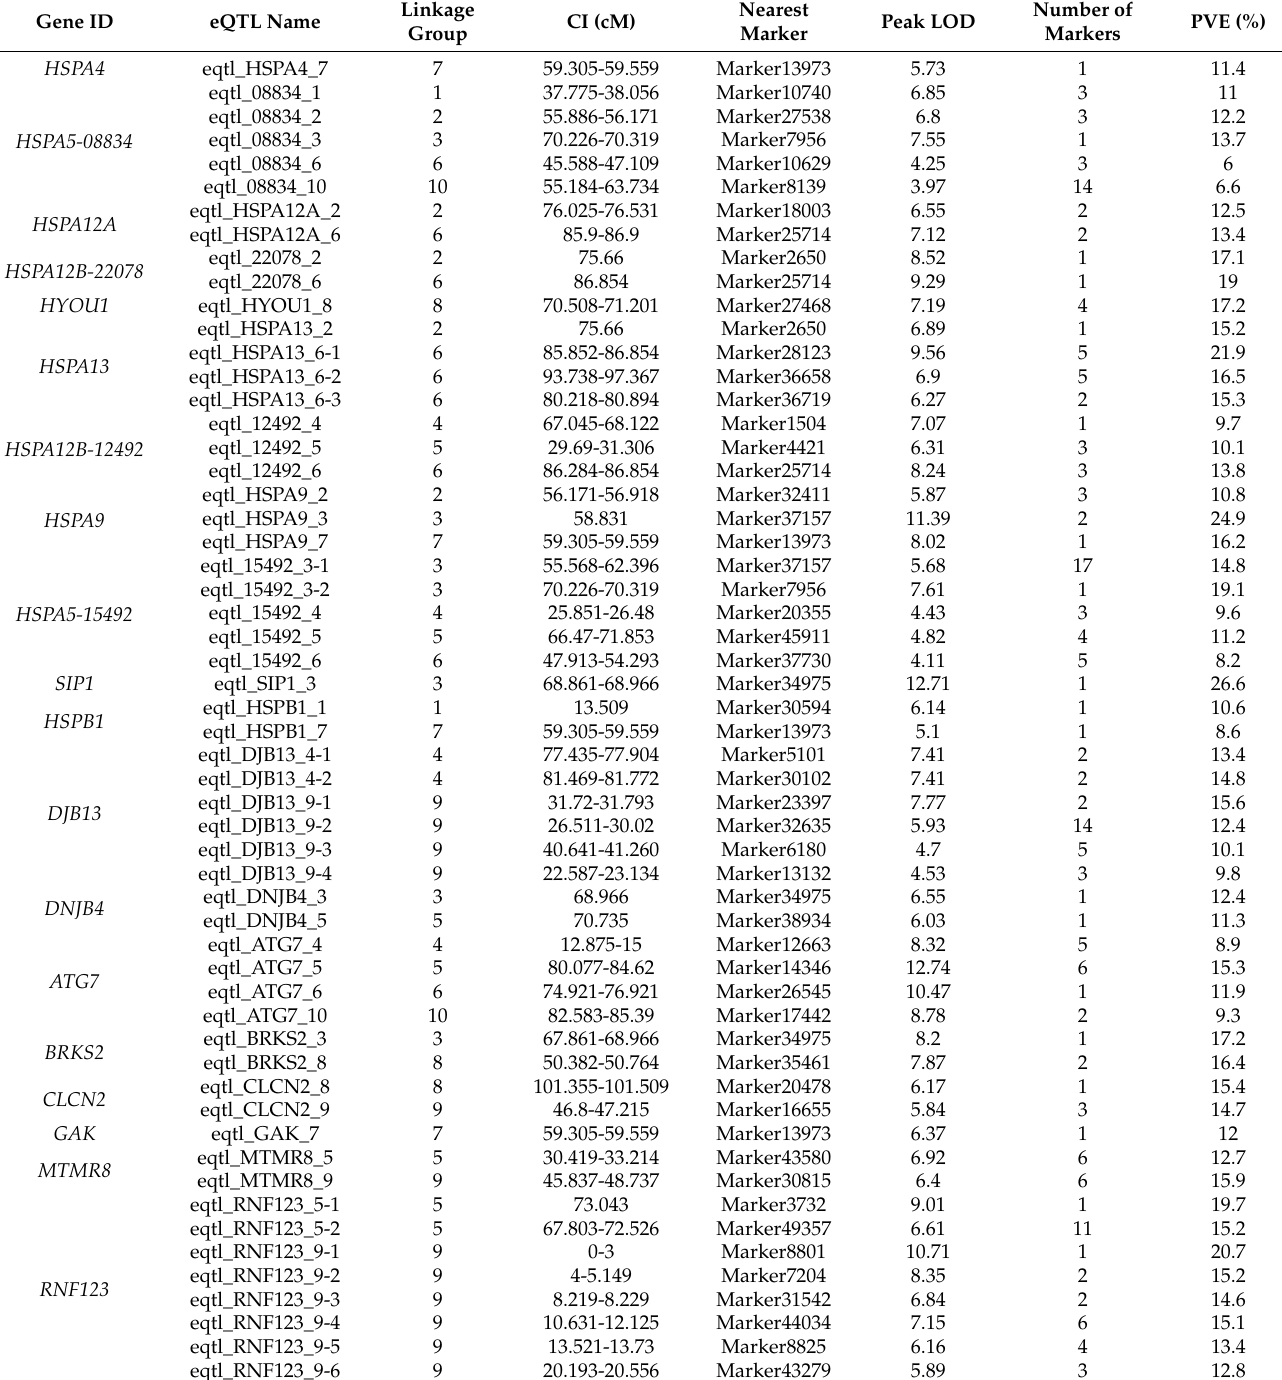
Table 2. Summary of candidate expression quantitative trait loci (eQTL) regions of 19 genes by eQTL mapping. eQTL names, linkage groups, confidence intervals (CIs), nearest markers, peak of LODs, number of markers, and phenotypic variation explanation (PVE) are shown in the